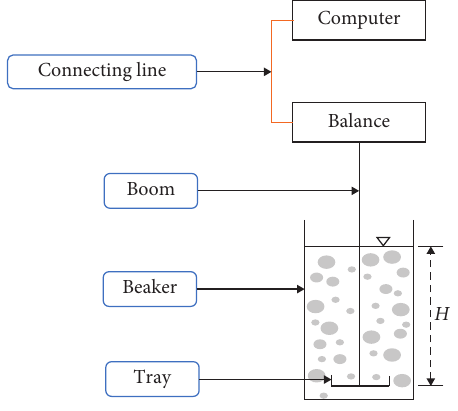
Figure 3: Settlement balance test.